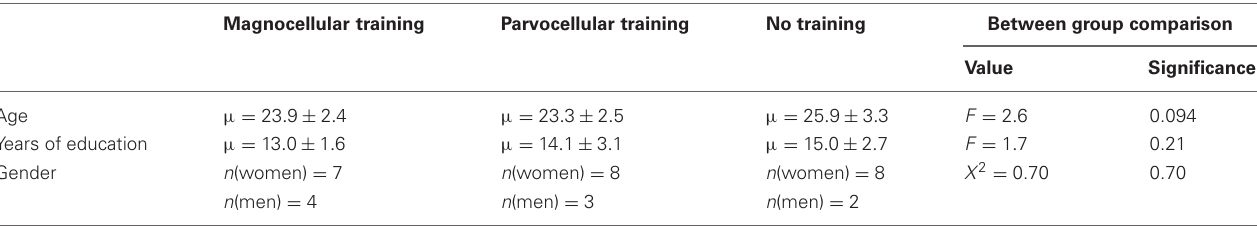
Table 1 | Descriptive statistics of age, years of education, and gender for training